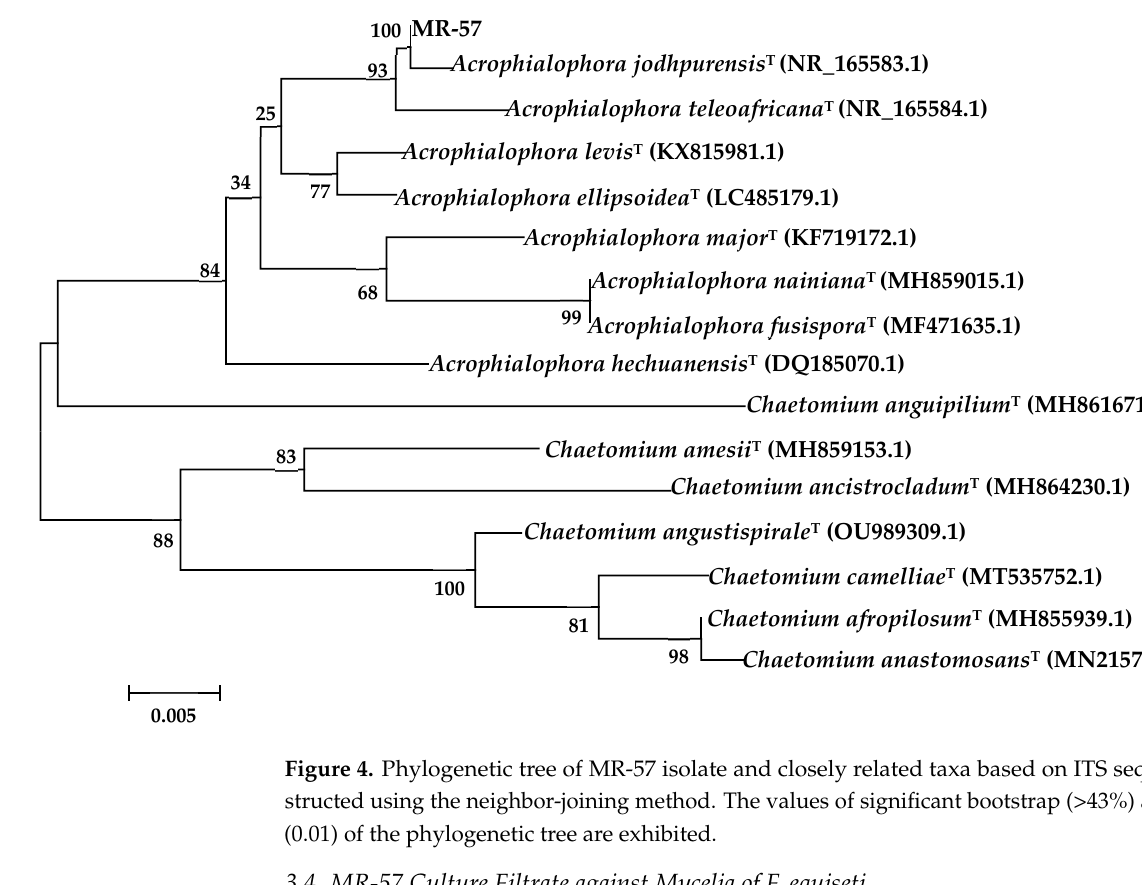
Figure 4. Phylogenetic tree of MR ‐ 57 isolate and closely related taxa based on ITS sequences, con ‐ structed using the neighbor ‐ joining method. The values of significant bootstrap (>43%) and the scale (0.01) of the phylogenetic tree are exhibited.